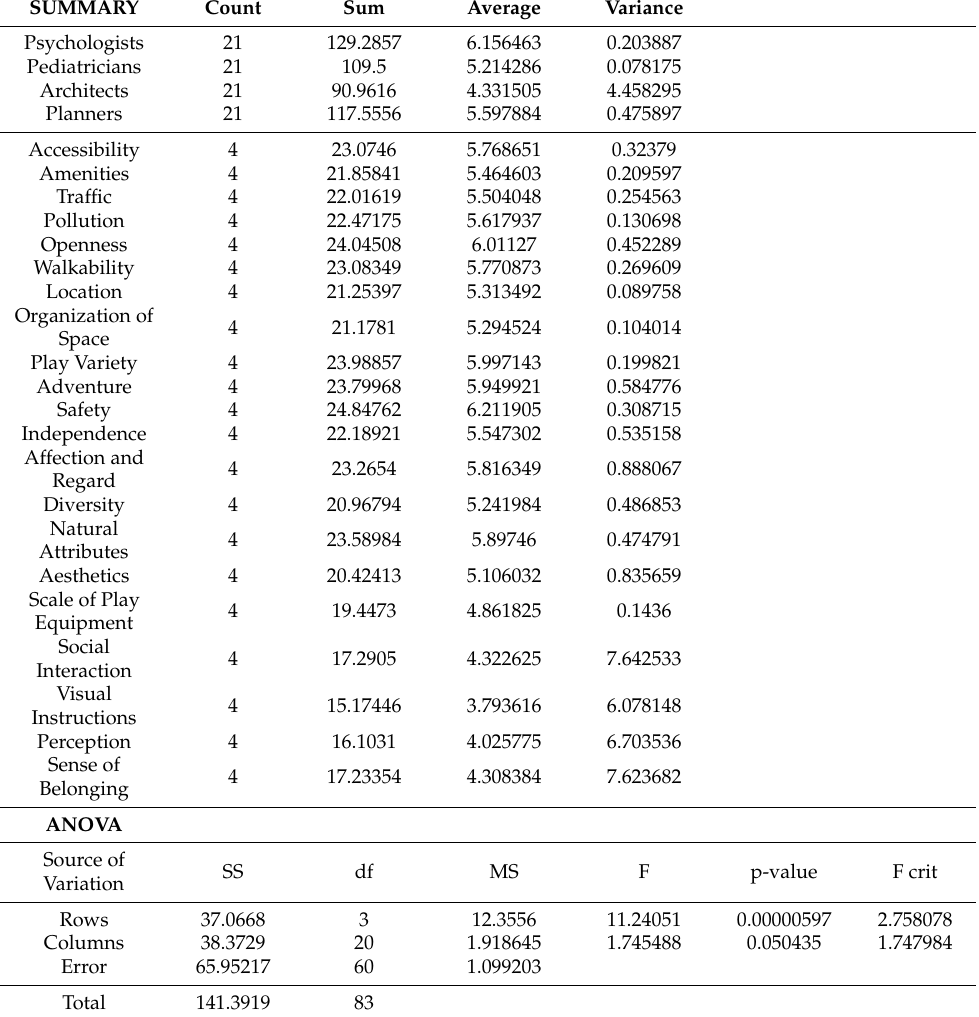
Table 9. ANOVA: Two-Factor Without